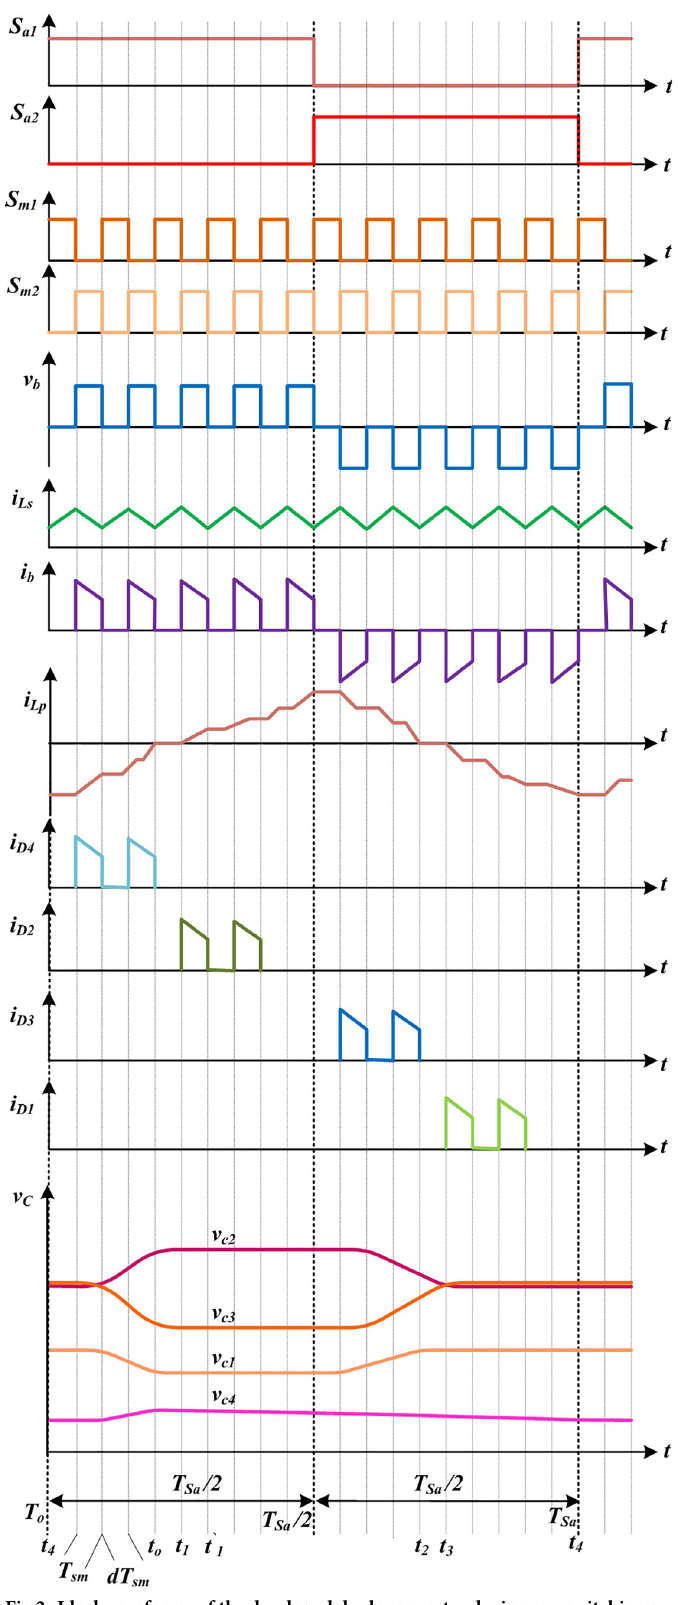
Fig 2. Ideal waveforms of the developed dc-dc converter during one switching period in CCM mode. https://doi.org/10.1371/journal.pone.0206691.g002 PLOS ONE | https://doi.org/10.1371/journal.pone.0206691 November30,